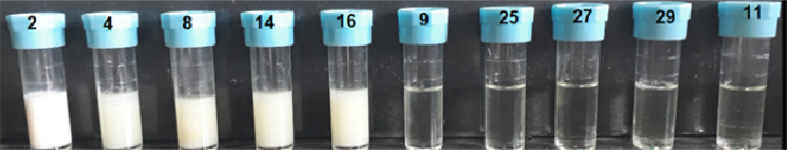
Study of microemulsion system stability in various component percentages.